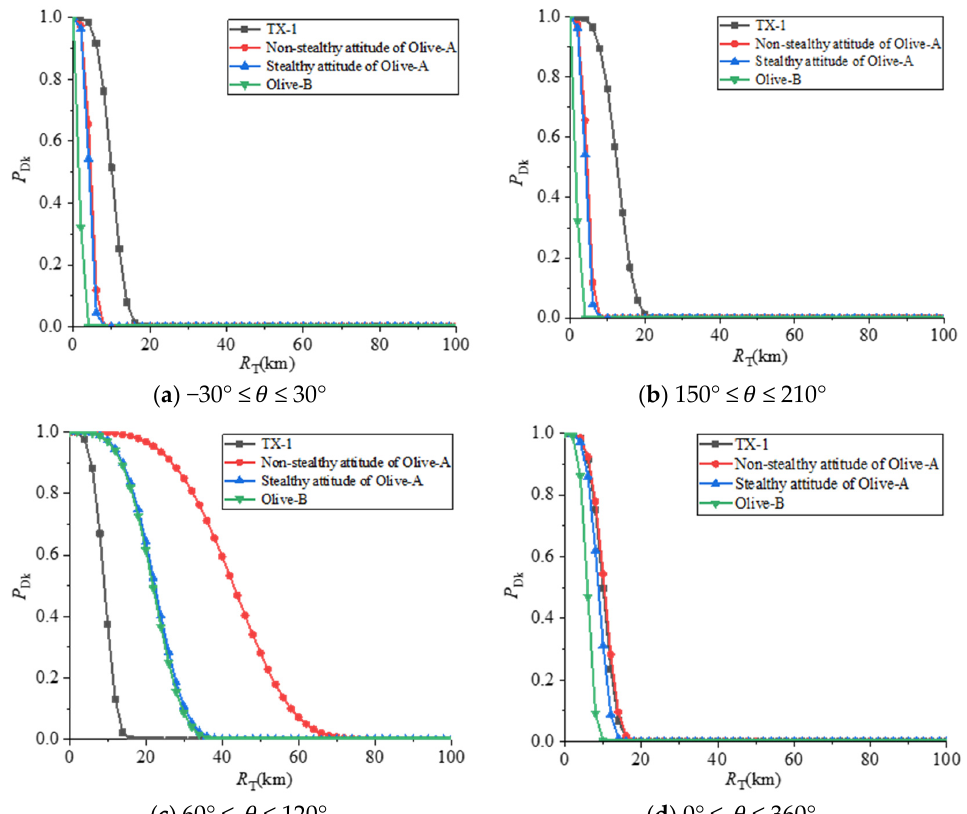
Figure 16. Detection probability of satellites under X-band radar. ( a ) Spaceward; ( b ) Groundward; ( c ) Lateral; ( d ) Omnidirectional.